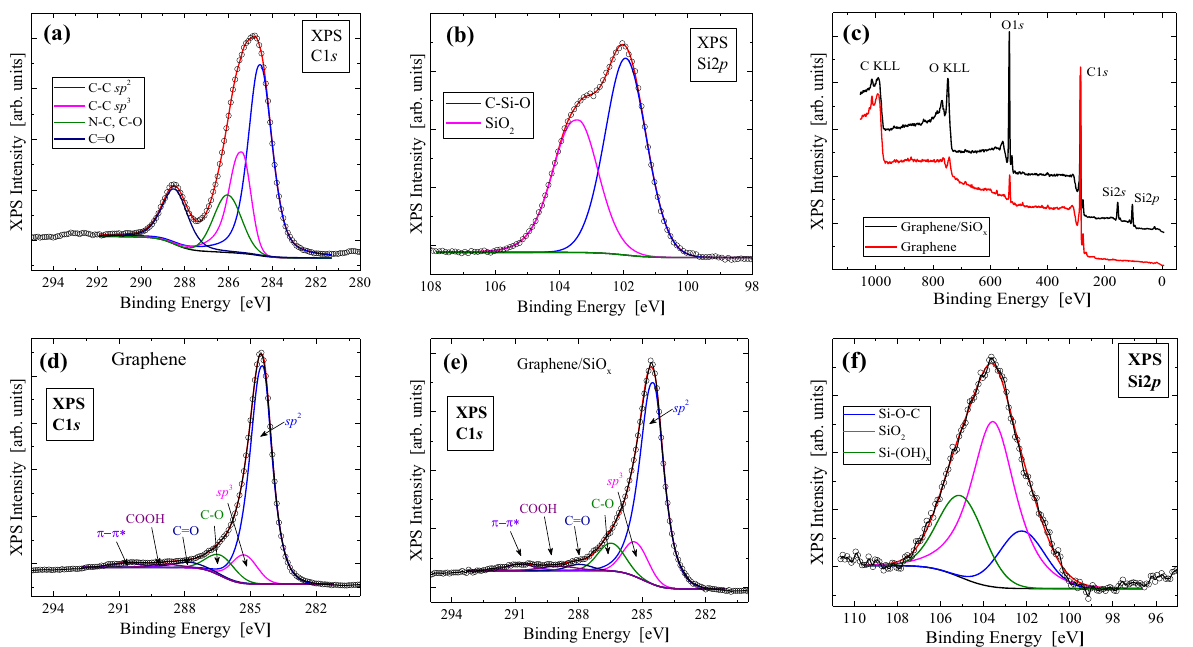
Fig. 5 Analysis of X-ray photoelectron spectra. Analysis of a C1 s from neat PI and b Si2 p from the silicone adhesive. c Survey scans of the laser-assisted produced graphene and graphene/SiO x materials. Analysis of XP spectra of the C1 s peak of d graphene and e graphene/SiO x . f Analysis of the Si2 p component of the graphene/SiO x nanohybrid.